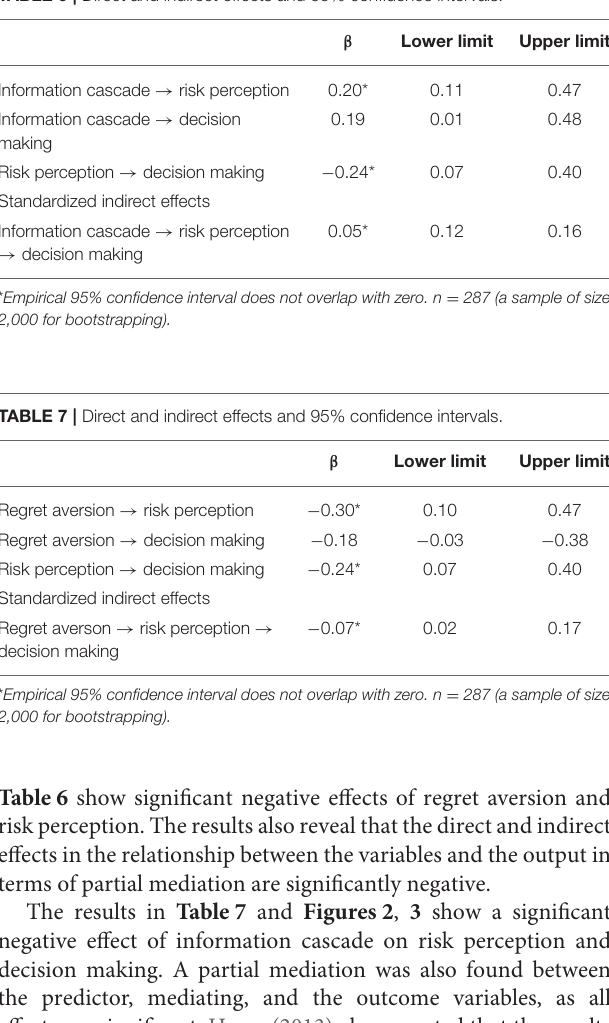
TABLE 5 | Reliability statistics. TABLE 6 | Direct and indirect effects and 95% confidence intervals.